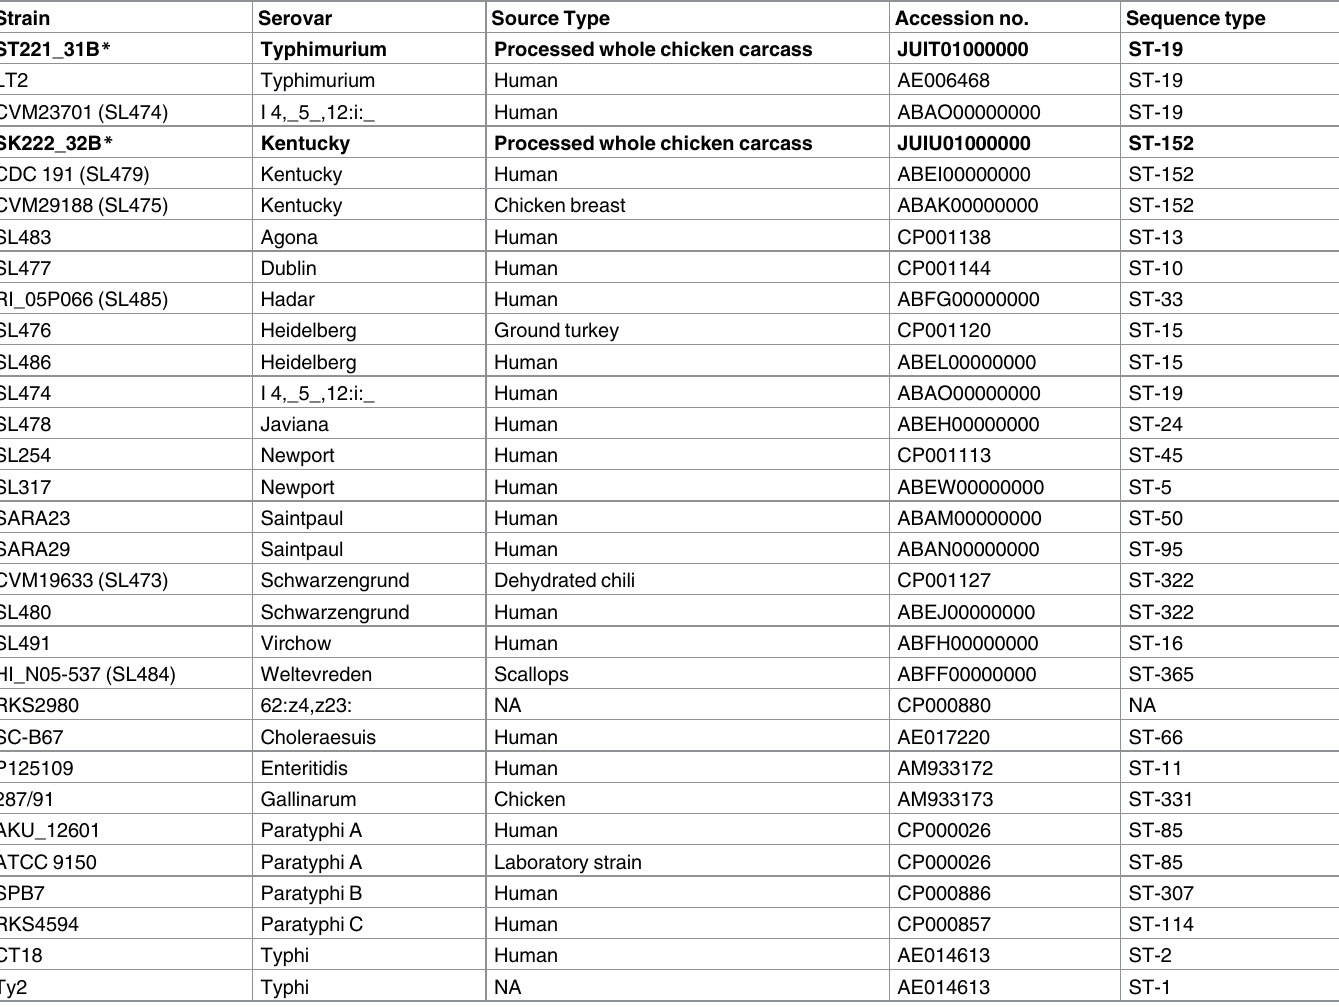
Table 1. List of strains used for phylogenetic analysis of S . enterica